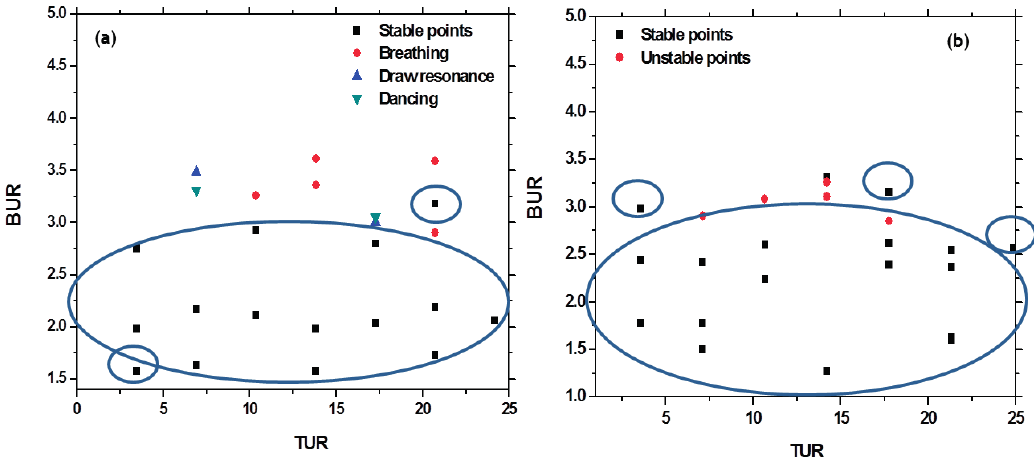
Figure 15. Stability maps of the ( a ) uncompatibilized PLA-PBAT blends and ( b ) compatibilized PLA–PBAT blends with 0.7 wt% of